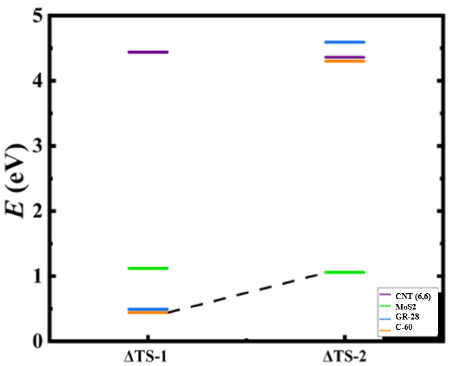
Figure 2. Calculated relative transition state barrier paths values for the two-step Oxidation–Reduction Reaction (ORR) of sulfur dioxide by utilizing armchair (6,6) carbon nanotube, molybdenum disulfide (MoS 2 ), 28 ‐ atomed graphene nanoflake (GR ‐ 28), and fullerene (C ‐ 60) as catalysts repre ‐ sented by the inset purple, green, blue, and orange bars, respectively. The black dashed line identi ‐ fies the optimal catalytic path for the transition states 1 and 2. The relative transition state barriers ( Δ TS ‐ 1) and ( Δ TS ‐ 2) for the respective steps 1 and 2 are defined by Equation (3): Δ TS = transition state–initial state.